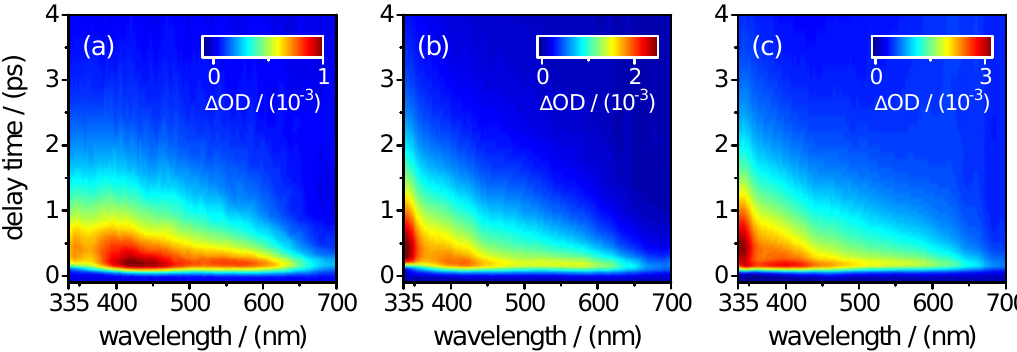
Figure 8. Two-dimensional maps of the observed changes in optical density in the transient absorption experiments on XMP − after excitation at: ( a ) λ pump = 278 nm; ( b ) λ pump = 260 nm; and ( c ) λ pump = 243 nm.